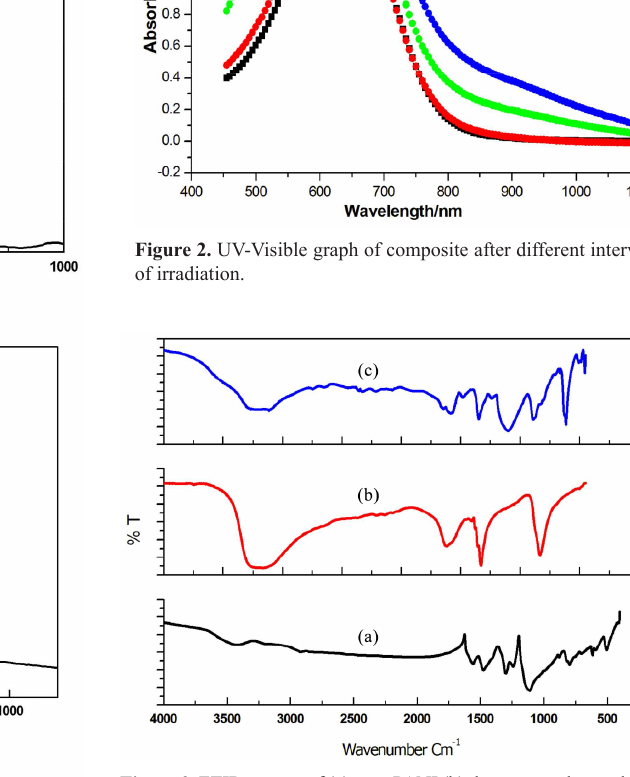
Figure 3. FTIR spectra of (a) pure PANI (b) dopant metal complex (c)